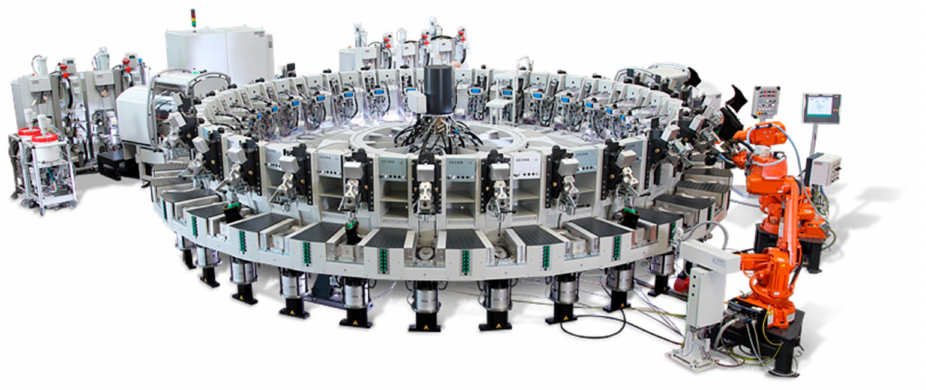
Figure 2. DESMA rotary machine equipped with two injectors and robotic cells. Courtesy of DESMA Schuh-maschinen